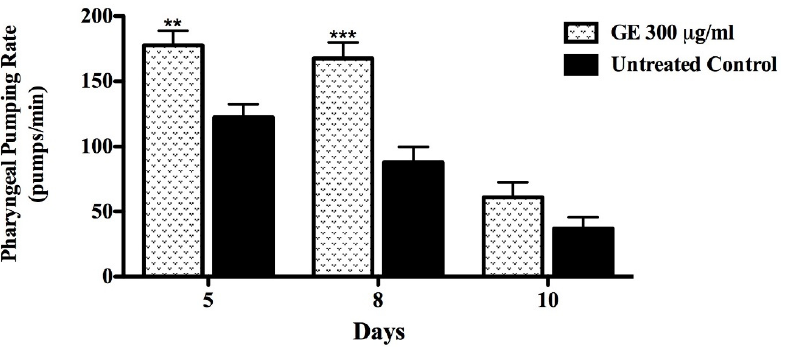
Figure 5. Pharyngeal pumping rate in N2 wt worms after GE treatment. The treatment with GE 300 µ g/mL significantly attenuated the age-associated decline in the muscle function of pharynx. Data are presented as mean ± SEM. ** p <0.01,*** p < 0.0001 related to the control by a two-way ANOVA. No impairment of the pumping activity of the pharynx was observed among GE treated worms; instead, the pumping rate was significantly higher compared to that scored among the untreated control. We assume that GE lifespan extension effect is not due to CR influence. Moreover, the attenuation of the age ‐ related muscle function decline, assessed in C. elegans by the activity of the pharynx, is indicative for the anti ‐ aging property of guarana extracts [29,30]. C. elegans pharynx muscle structure undergoes progressive deterioration and function decline with age, similarly to the